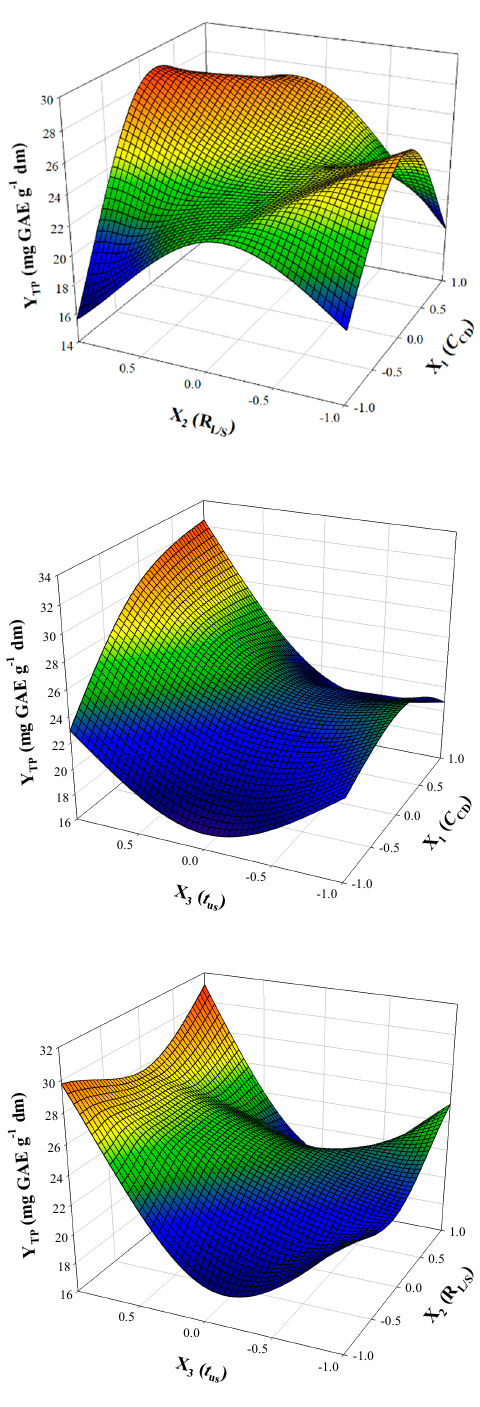
Figure 3. 3D graphs illustrating the effect of simultaneous changes in process (independent) variables on the response.